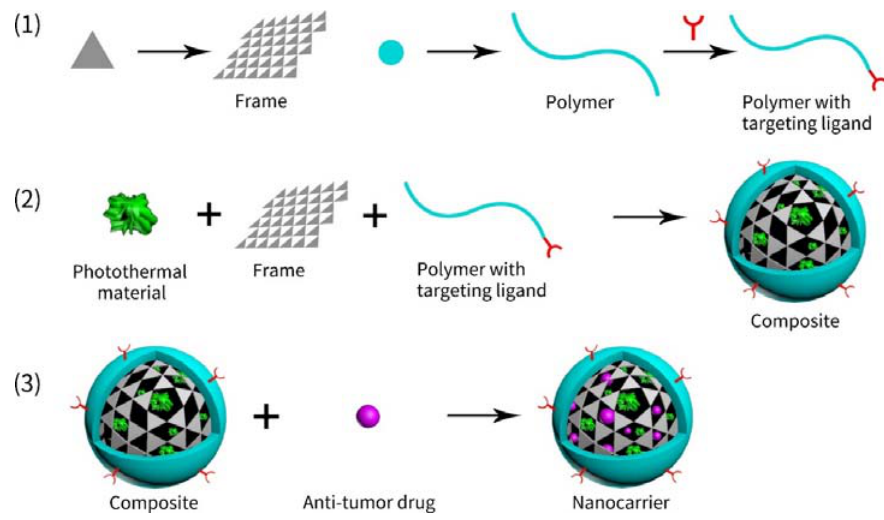
Figure 4. Schematic illustration of preparing frame ‐ coat structured nanocarriers.